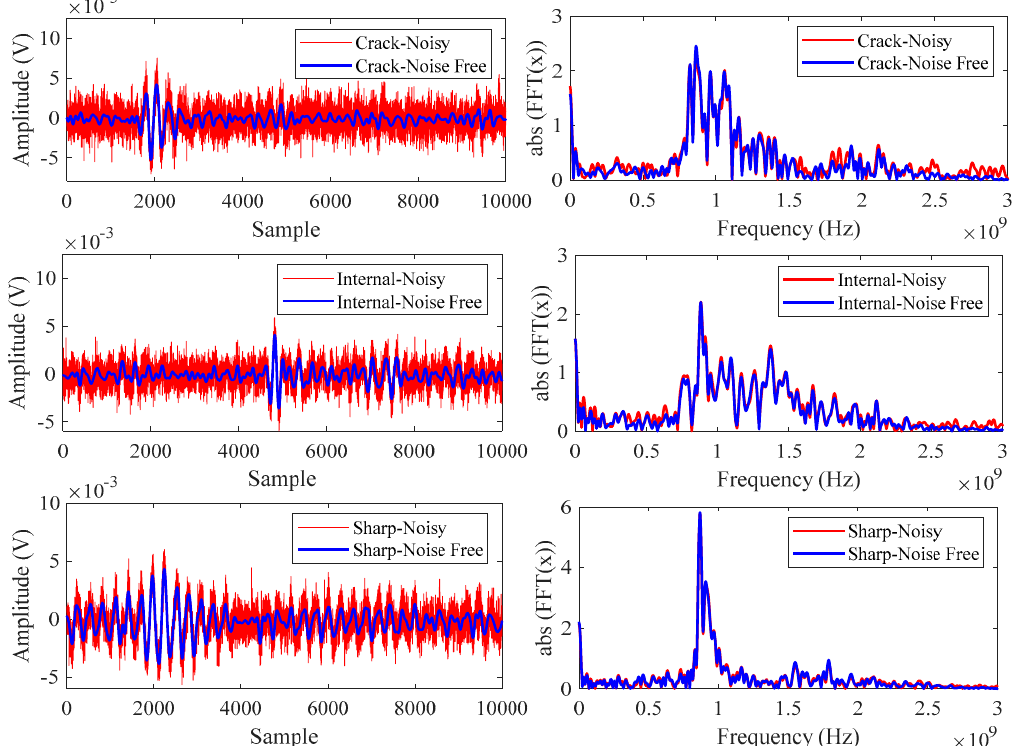
Figure 5. Three RF signals emitted from the different sources of partial discharge in the insulator discs including crack, internal void, and sharp point types and their frequency spectrum both in noisy and noise free conditions.